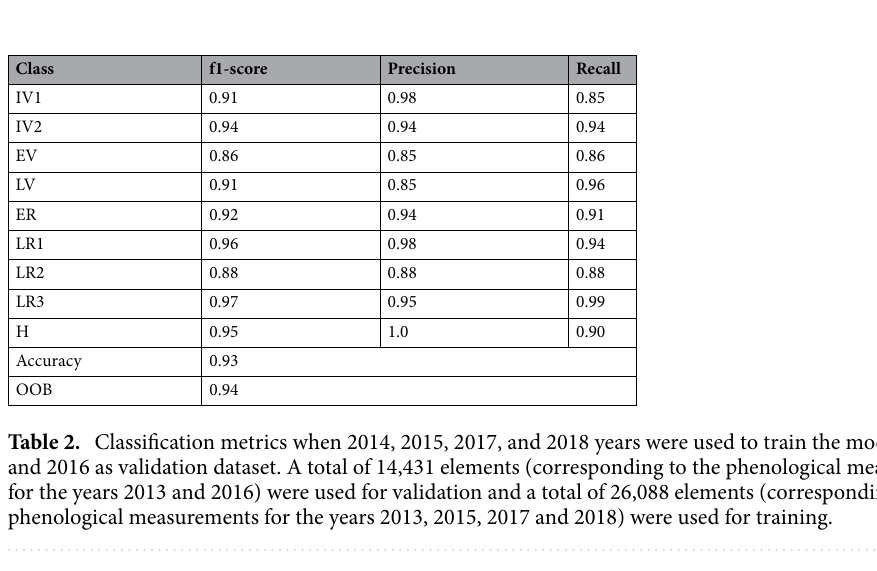
Class f1-score Precision